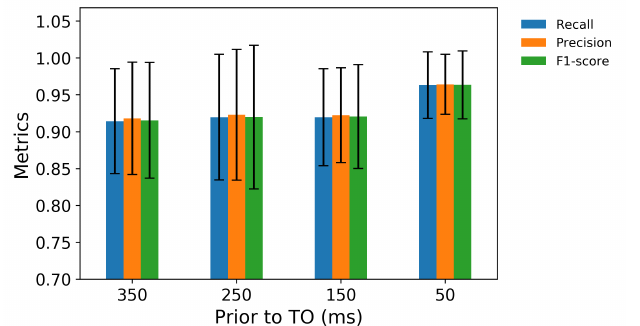
Figure 4. The precision, recall, and F1-score for predictions of transitions from level-ground walking 350, 250, 150, and 50ms prior to